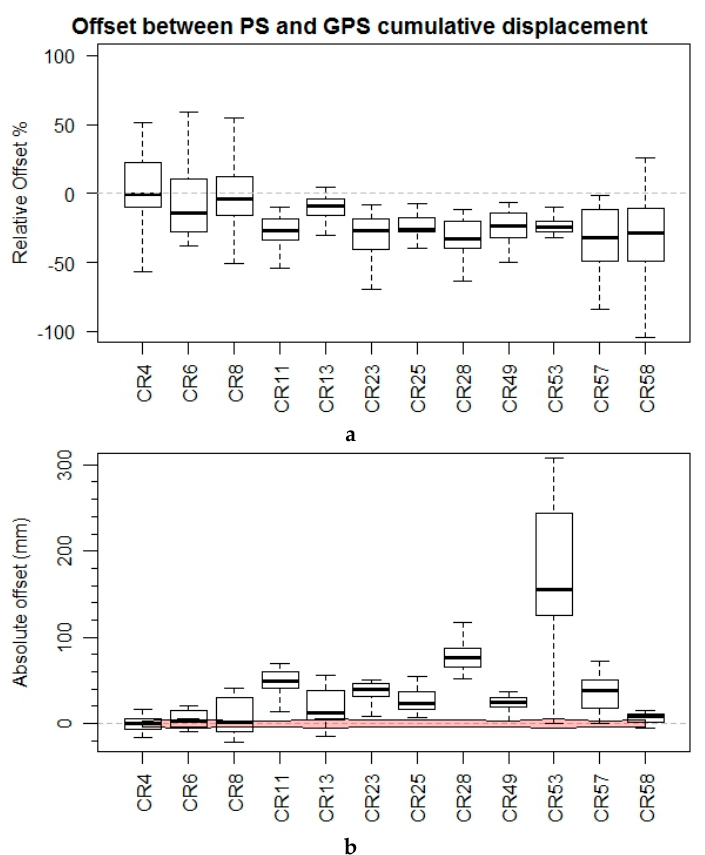
Figure 6. Evaluation of PS-MTI and GPS-LOS cumulative displacement time-series: ( a ) relative offset; and ( b ) absolute offset. The red shaded area represents the median GPS error computed for each monitoring point. Boxplots represent the 1st and 3rd quartiles (limiting the bottom and top of the boxes) and the median (2nd quartile) is depicted by the black horizontal line. Whiskers represent the difference between the 1st quartile and 1.5 times the Inter Quartile Range (IQR), bottom whisker, and the 3rd quartile minus 1.5 times the IQR, top whisker.